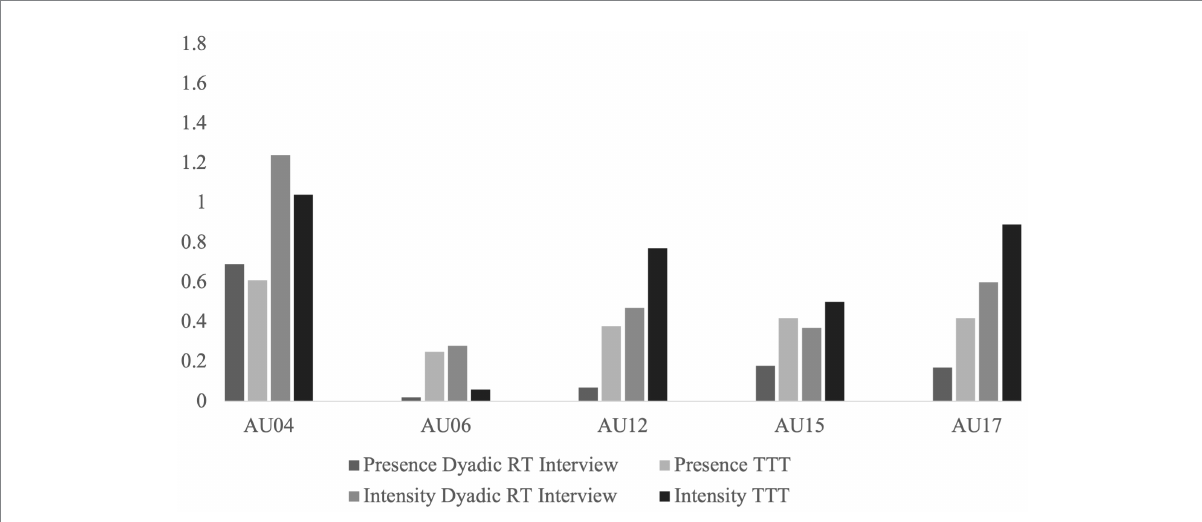
FIGURE 7 Descriptive statistics of the behavior measures for Colette. Mean of action unit (AU) presence and intensity for Colette across two contexts; dyadic reminiscence therapy (RT) interview, and technology-driven group reminiscence therapy (TTT). The orange and green columns represent the RT context, and the yellow and brown columns represent the TTT context. The presence of the AUs represents the percentage of time the AU was present from 0 (not present) to 1 (always present). The intensity of the AUs represents the intensity of the AU movement on a continuous scale from 0 (min) to 5 (max).